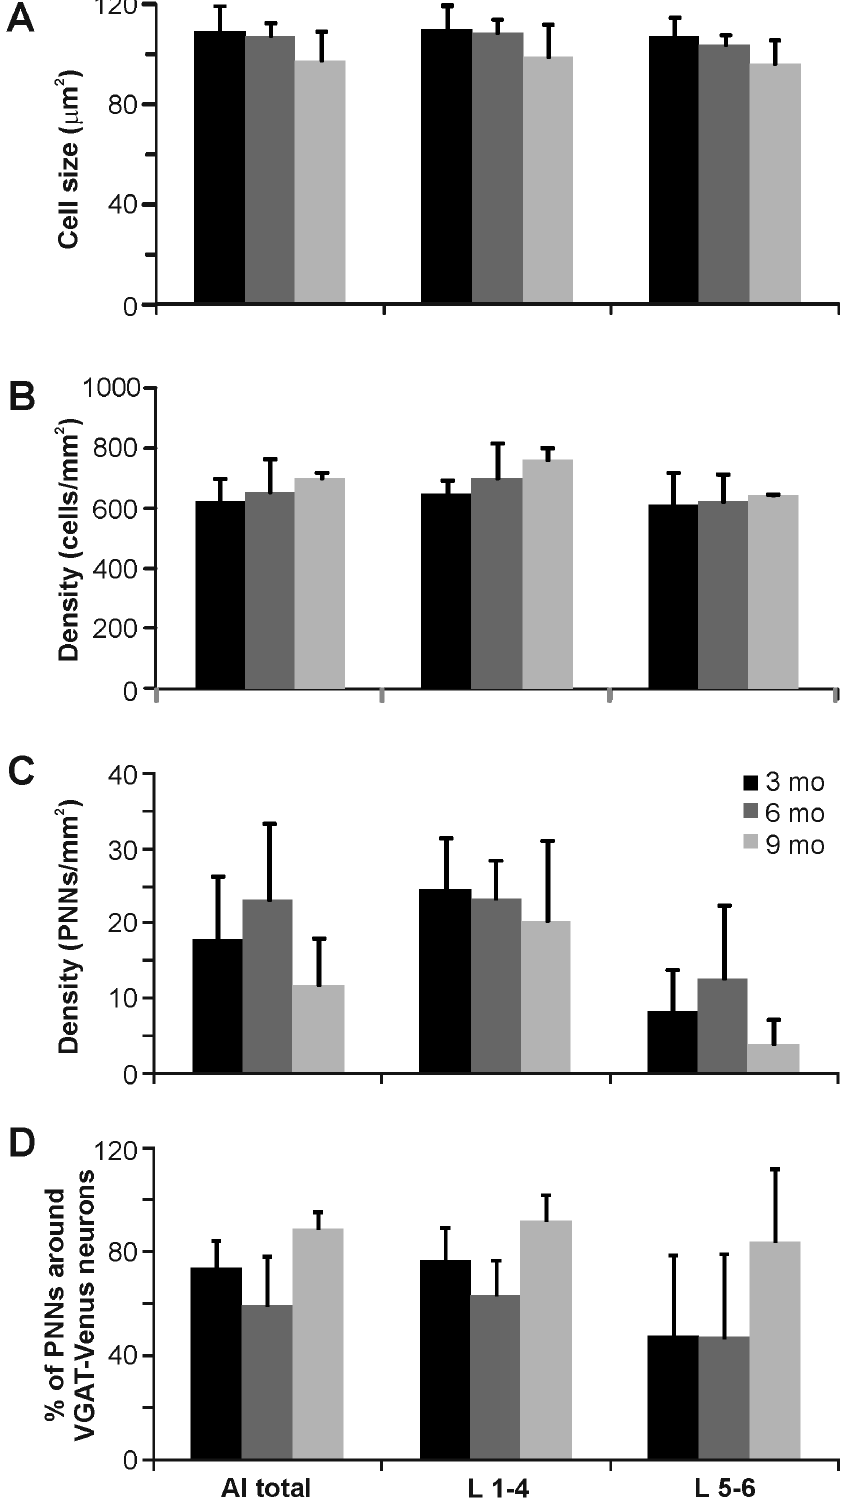
Figure 7. Quantification of vesicular gamma-amino butyric acid transporter (VGAT)-Venus neurons and perineuronal nets (PNNs) in the auditory cortex by layer and age in the VGAT-Venus C57BL/6 mouse strain: ( A ) average cell size ( μ m 2 ) of VGAT-Venus positive neurons was similar across layers and areas; ( B ) density of VGAT-Venus positive cell bodies was an order of magnitude greater than perineuronal net density; ( C ) density of PNNs was greater in upper layers (L1–4) than lower layers (L5–6) of auditory cortex; and ( D ) more than half of all PNNs were found surrounding Venus-positive cells.